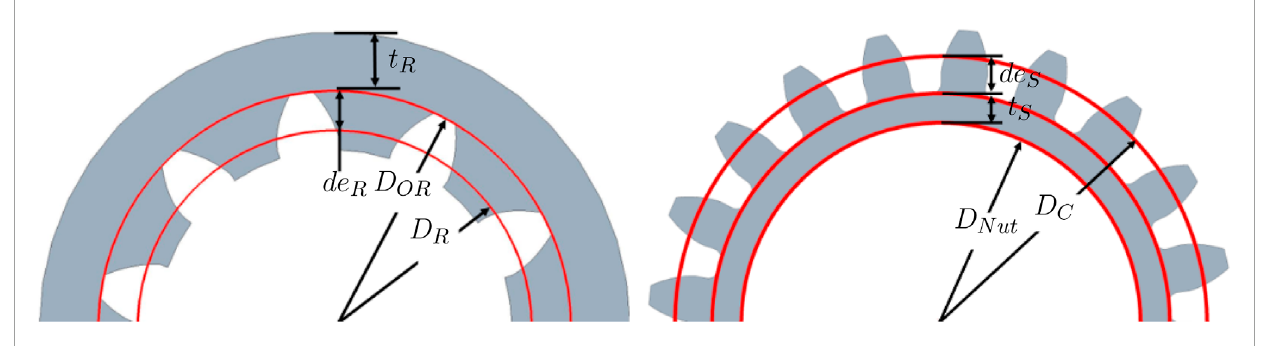
FIGURE 5 Ring gear and sun gear dimensions.